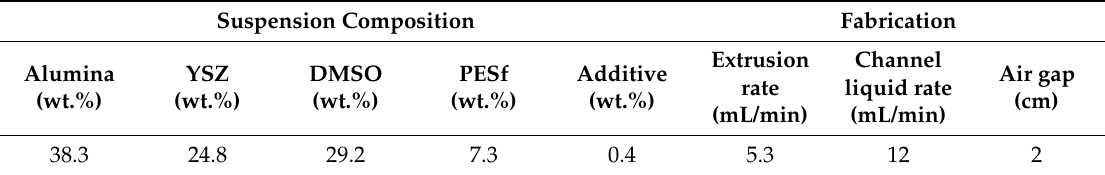
Table 1. Fabricating parameters of the seven-channel Al 2 O 3 -YSZ capillary membrane. Suspension Composition